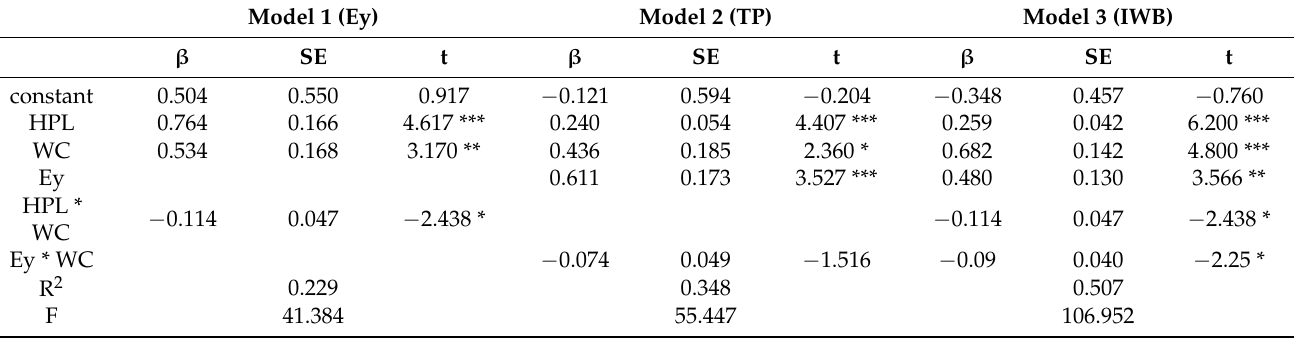
Table 5. Moderated mediation model testing.